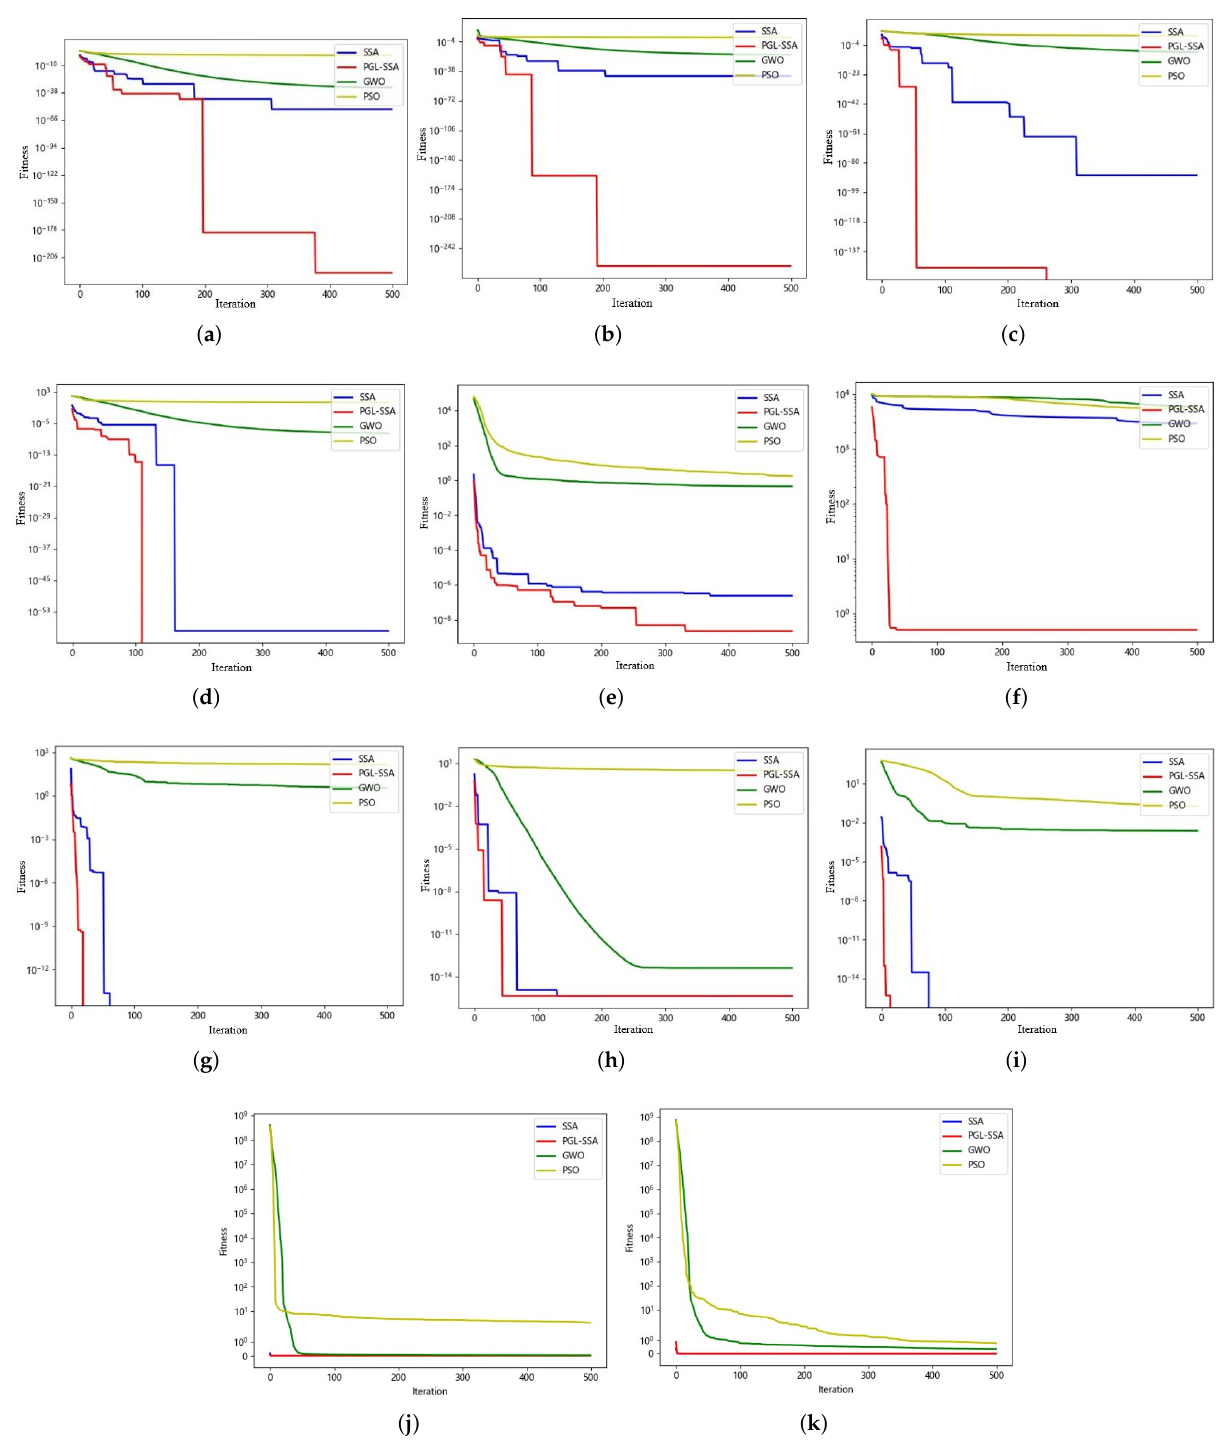
Figure 4. Different algorithms convergence curves of F1–F11 with 30 dimensions. ( a ) F1 Convergence curve. ( b ) F2 Convergence curve. ( c ) F3 Convergence curve. ( d ) F4 Convergence curve. ( e ) F5 Convergence curve. ( f ) F6 Convergence curve. ( g ) F7 Convergence curve. ( h ) F8 Convergence curve. ( i ) F9 Convergence curve. ( j ) F10 Convergence curve. ( k ) F11 Convergence